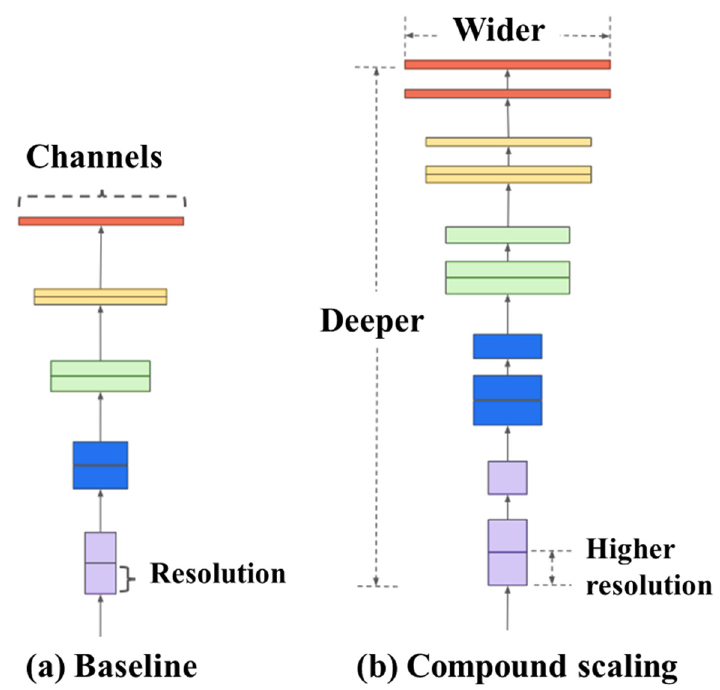
Figure 4. EfficientNet. Figure 4. E ffi cientNet. Figure 4. E ffi cientNet.